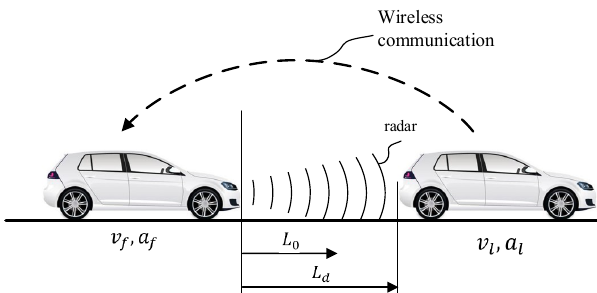
Figure 1. Scheme of the car-following scenario in this paper.